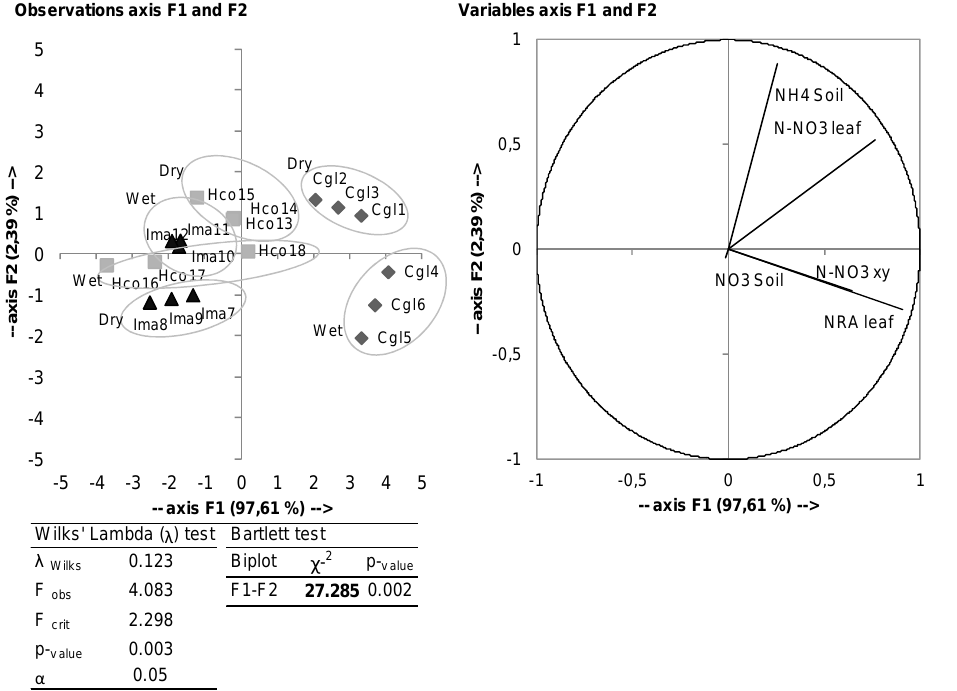
Figure 1. Biplot diagram of the factorial discriminant analysis (FDA) indicating the correlation between nitrogen use variables for each species’ subject. Nitrate reductase activity (NRA), nitrate in leaves (N-NO − 3leaf ), xylem sap (N-NO − 3xy ) and in soil (N-NO − 3soil ) for Cgl ( Cecropia glaziovi ), Ima ( Inga marginata ) and Hco ( Hymenaea courbaril ).